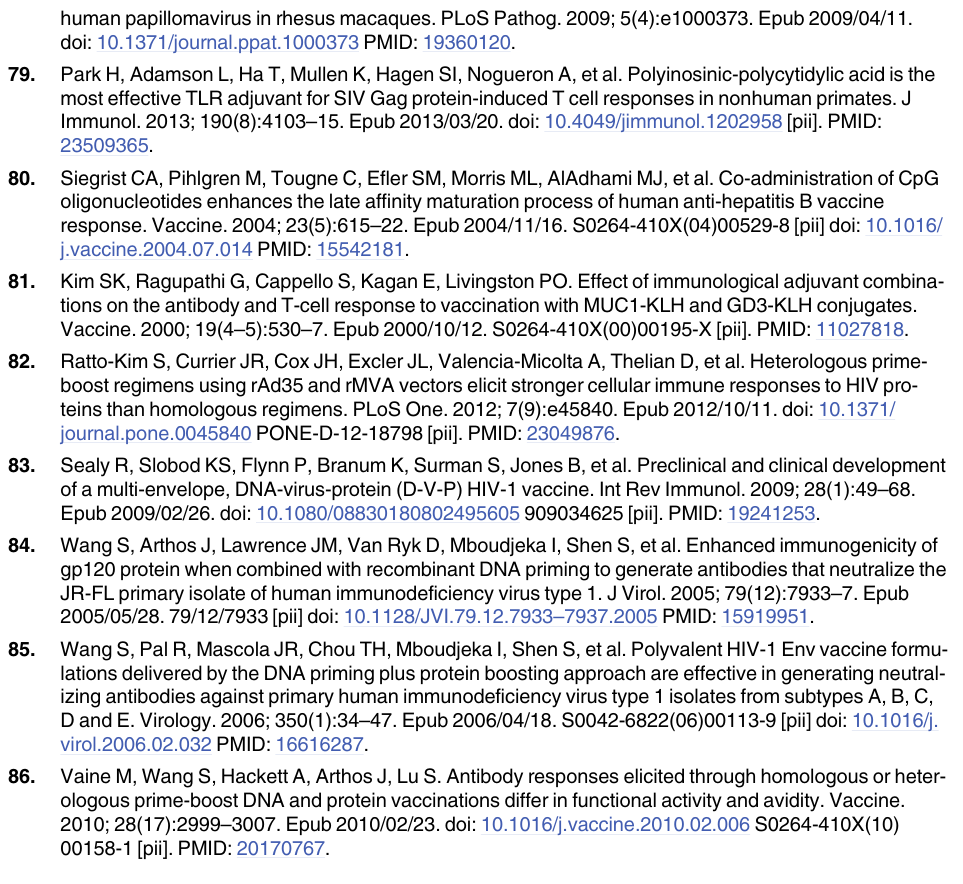
PLOS ONE | DOI:10.1371/journal.pone.0145637 January 4,